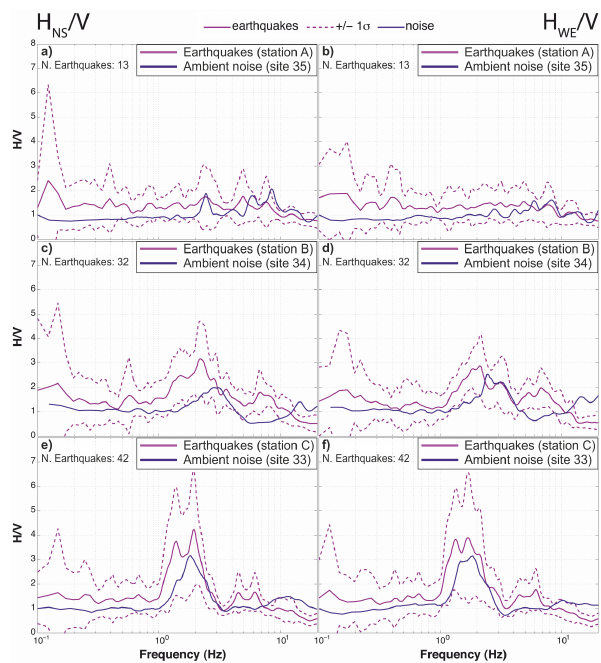
Figure 5. HVSR curves obtained from earthquake data (pink curves) and the ambient noise measurement (blue curves) for both horizontal components (H NS /V, left panels; H WE /V, right panels).